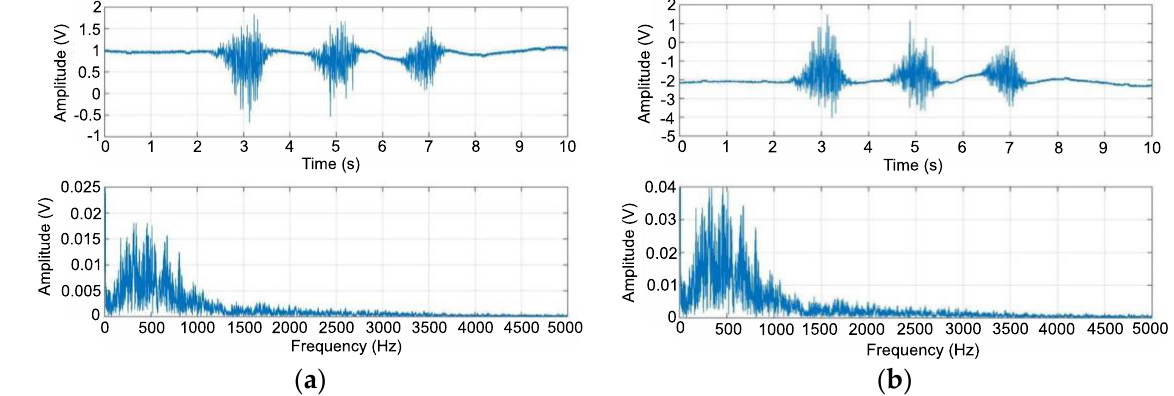
Figure 9. EMG signal as a function of time and frequency after amplification using instrument amplifier ( a ), EMG signal as a function of time and frequency after amplification using inverting amplifier ( b ).